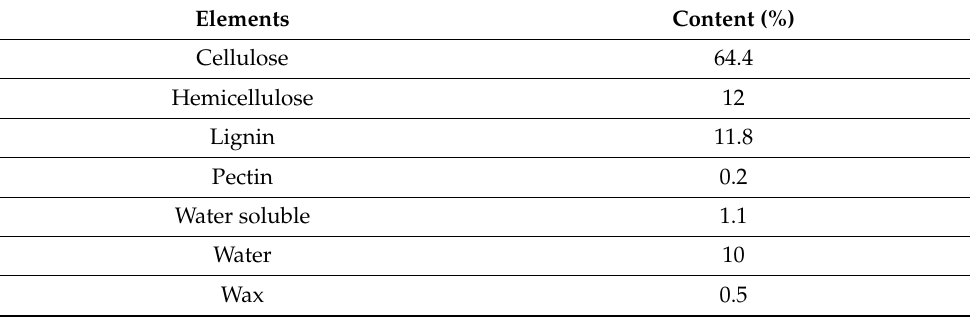
Table 2. Chemical composition of jute fiber [23].